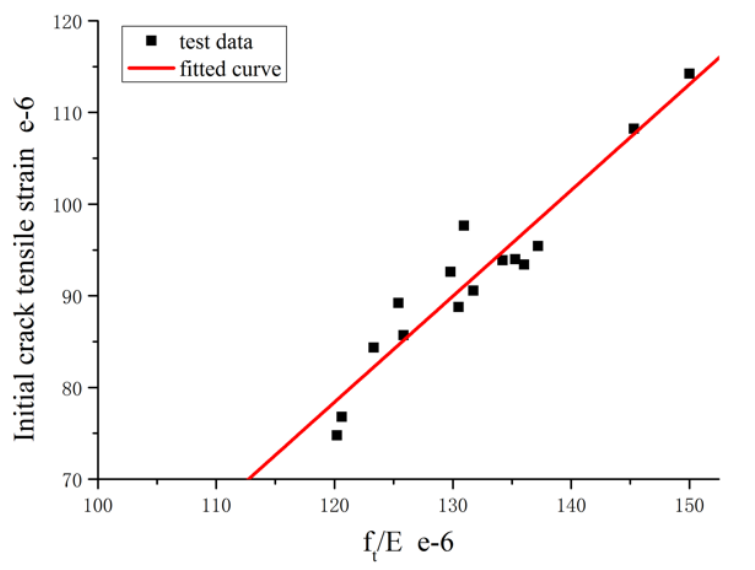
/𝐸 . Figure 8. Relationship between initial crack tensile strain and f t / E . 𝑡